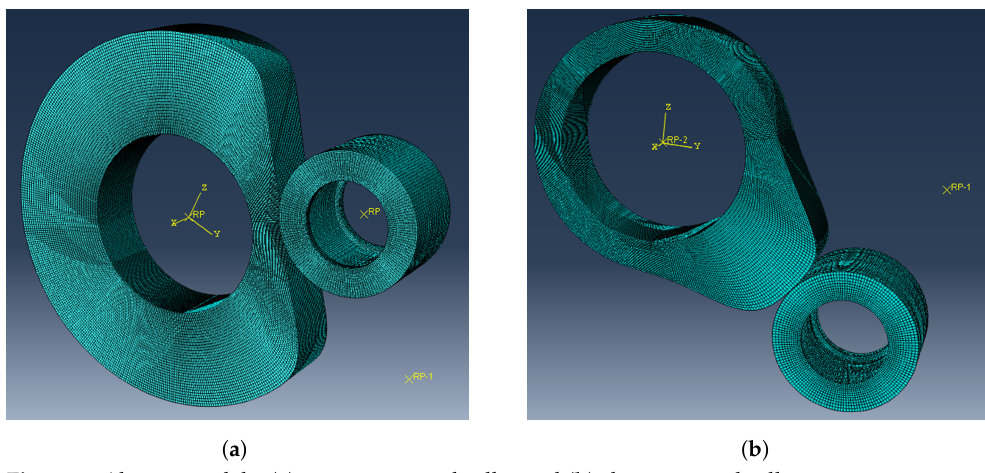
Figure 5. Abaqus models: ( a ) master cam and roller and ( b ) slave cam and roller. Both LPM and FEM are evaluated in terms of the angular displacement ψ (cid:48) of the follower arm (output) resulting from a constant torque (input) applied on the follower axes for both of the master and slave subsystems shown in Figure 5. In order to appreciate the quality of the LPM with respect to the FEM, the static transmission error STE is introduced as a performance metric; it is defined as the difference between the kinematic follower angle ψ and follower angle computed at the static equilibrium ψ (cid:48) for each discrete cam configuration θ i